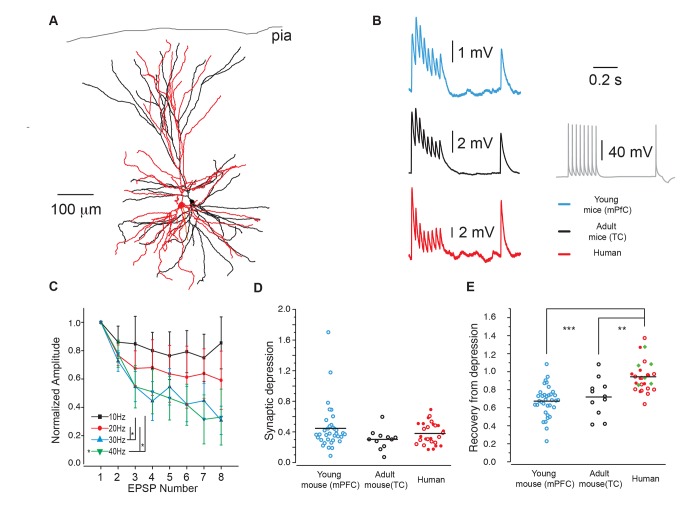
Synapses in the adult human neocortex rapidly recover from depression.(A) Digital reconstruction of a biocytin-filled, synaptically connected pair of layer 2/3 pyramidal neurons in human temporal cortex. (B) Experimentally recorded EPSPs, generated by presynaptic timed APs at 30 Hz followed by a recovery pulse, 500 ms after the 8th pulse. Traces in blue are from young murine medial prefrontal cortex (mPFC) (P12–36), black, from murine temporal association cortex (10–11 weeks) and red from human temporal cortex. Grey is an example of a train of human presynaptic APs. Examples are averages of 30 repetitions. (C) Activity dependence of human short-term synaptic depression. Normalized average EPSPs (three pairs) generated in response to different frequencies (10–40 Hz). (D) Ratio 8th/1st EPSP (mean ± SEM) 0.38±0.03 human, 0.44±0.05 for young mouse synapses and 0.30±0.04 for adult mouse synapses (p>0.05). (E) Ratio 9th/1st EPSP (mean ± SEM) 0.94±0.03 for human, whereas young mouse EPSPs were still depressed 0.67±0.03 (p<0.001) and adult mouse EPSPs 0.72±0.06 (p<0.001). Difference between young and adult mouse ratios were not significant (p = 0.7). Human n = 27 (14 from tumor patients and 13 from epilepsy patients, see Materials and Methods); young mouse n = 35; adult mouse n = 11. Filled red circles, human tumor patients; open red circles, human temporal lobe epilepsy patients (300 ms interval between 8th and 9th EPSP). Open blue circles, young mouse group p12–p36; open black circles, adult mouse group 8–11 weeks. Filled green diamonds, human patients with 500 ms interval between 9th and 8th EPSP. (Data deposited in the Dryad repository, http://doi.org/10.5061/dryad.3723p
[56]: Data of neuronal reconstructions in Figure 1A.rar; Raw data of human and rodent EPSPs in 30 Hz_EPSPs.rar; Numerical data that generated (B–E) as well as Figure S1A–S1D in Data S1).